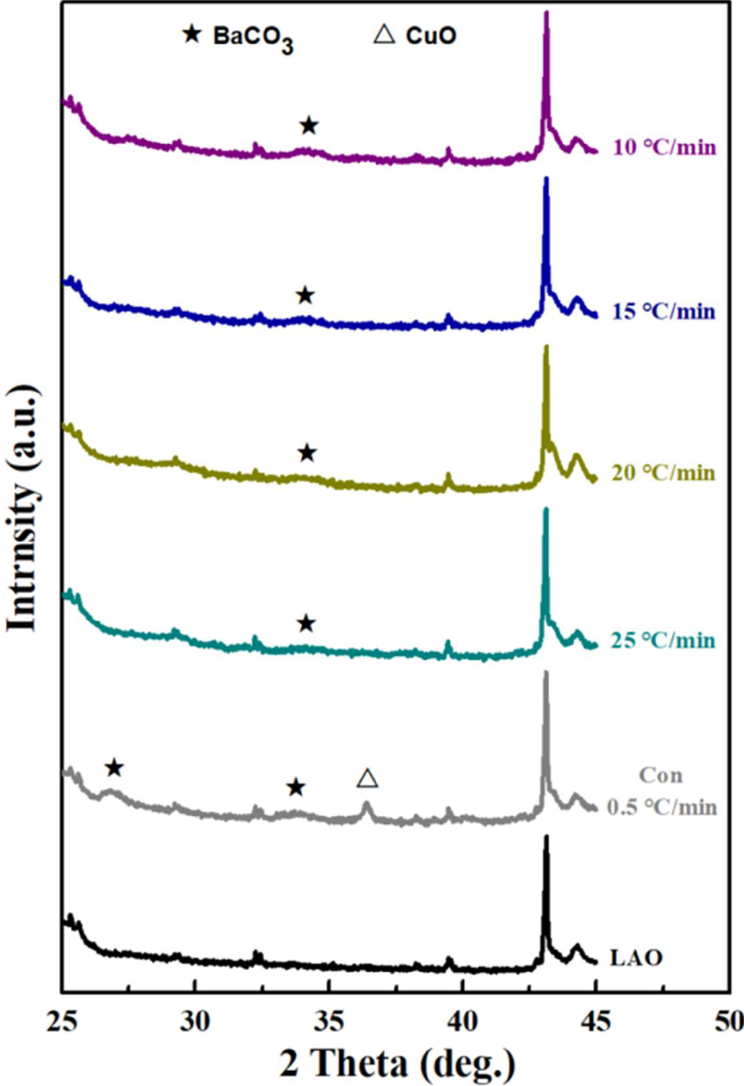
Figure 3. The θ – 2 θ X-ray diffraction patterns of low-vacuum pyrolysis film, conventional film (Con) and LaAlO 3 substrate. The heating rates are indicated on the right side.